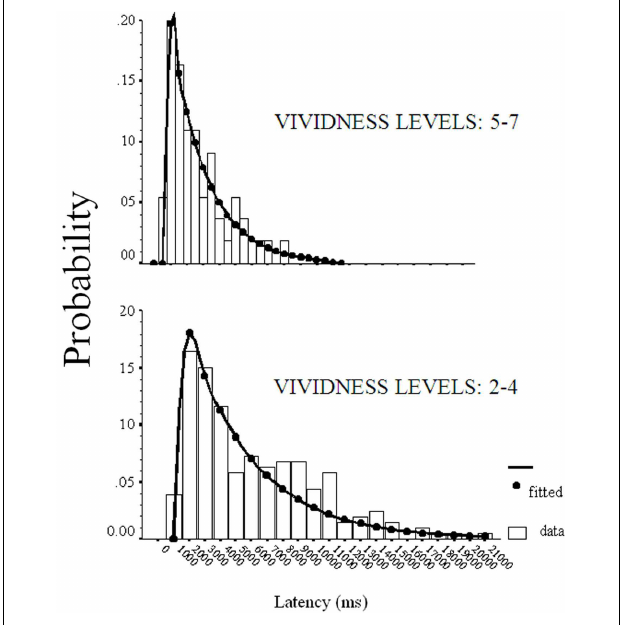
FIGURE 1 | Ex-Gaussian model-fit of RT distributions for images rated with vividness 2–4 and 5–7 in Experiment